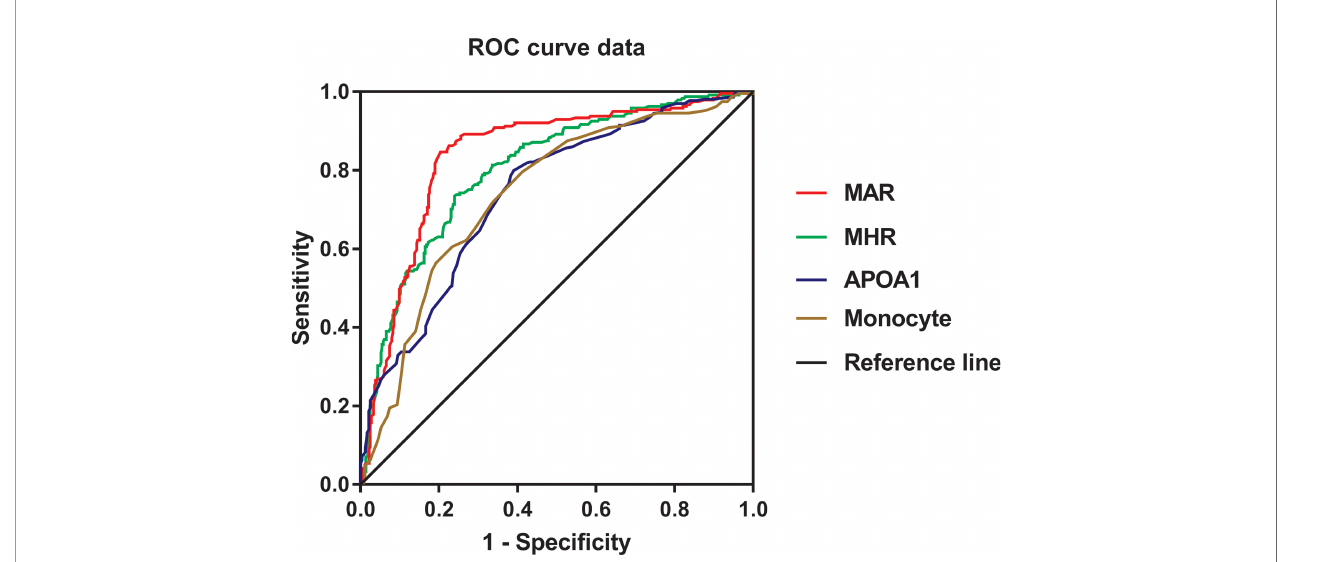
FIGURE 2 | Receiver operating characteristic curves for the cutoff value of MHR, MAR, monocyte, and ApoA1 to identify